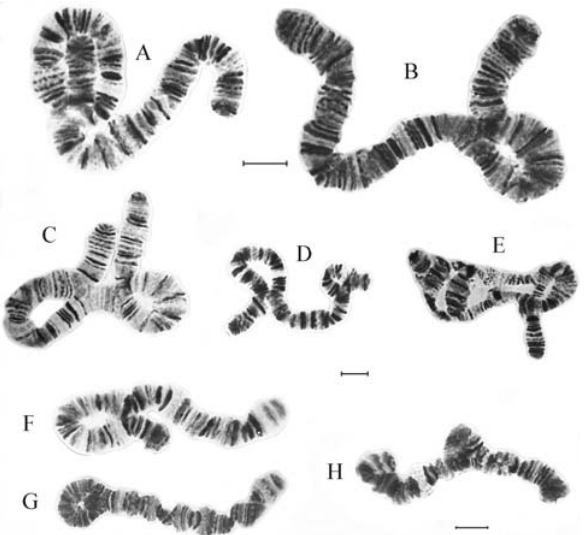
Figure 3 - Polymorphic inversions of Drosophila annulimana chromo- some 4. A: heterozygous inversion 4a; B: heterozygous inversion 4b; C: heterozygous inversions 4a and 4b; D: heterozygous inversions 4a and 4c; E: heterozygous inversions 4a, 4b, and 4c; F: heterozygous inversion 4f; G: heterozygous inversion 4g; H: heterozygous inversion 4h. Scale bars = 10 μ m.